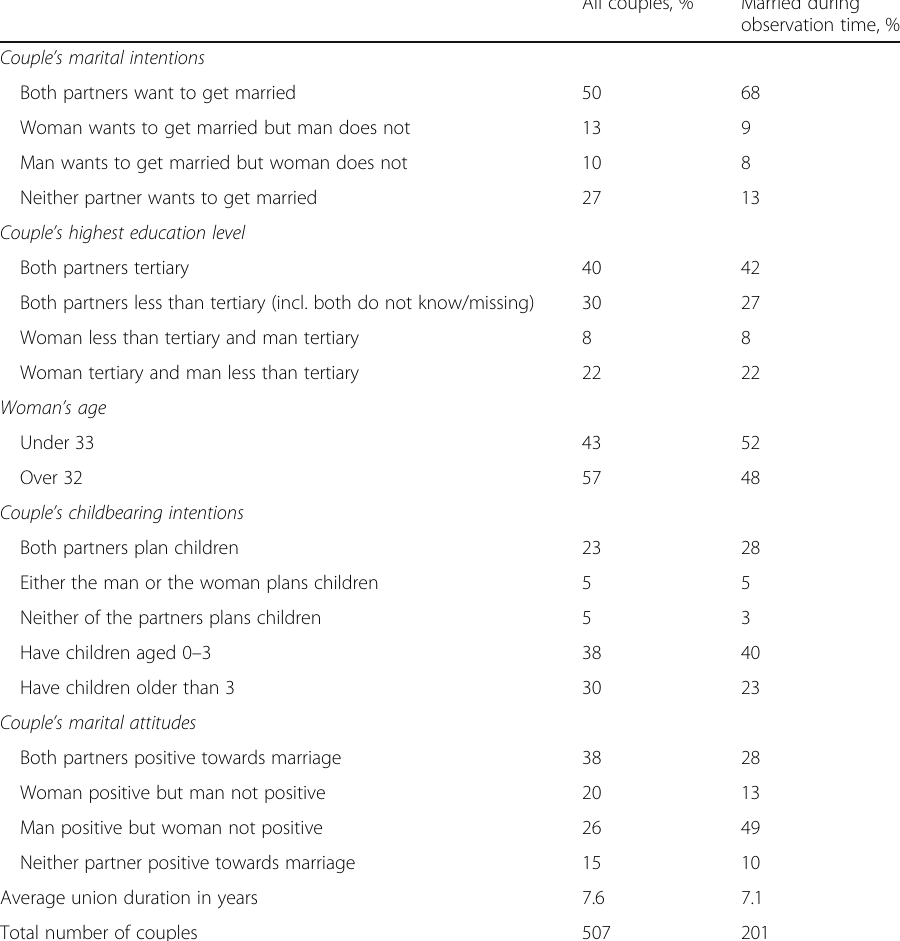
All couples, % Married during observation time, %